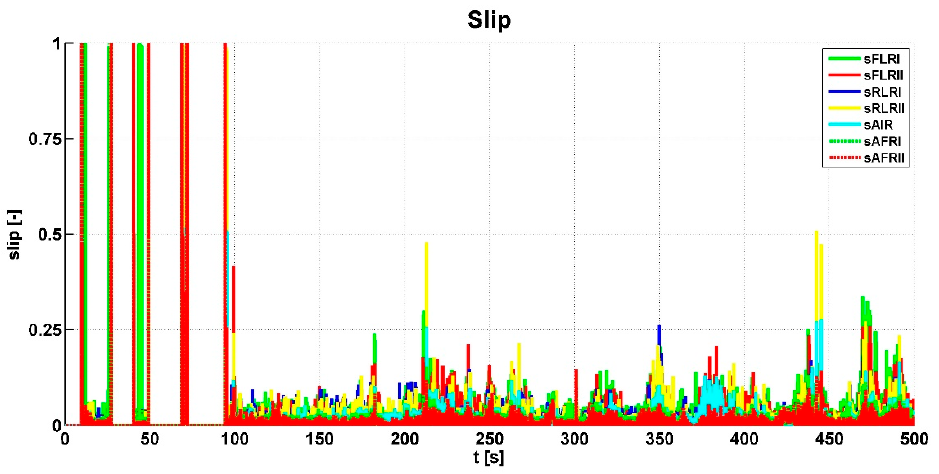
Figure 7. Wheel speed values.